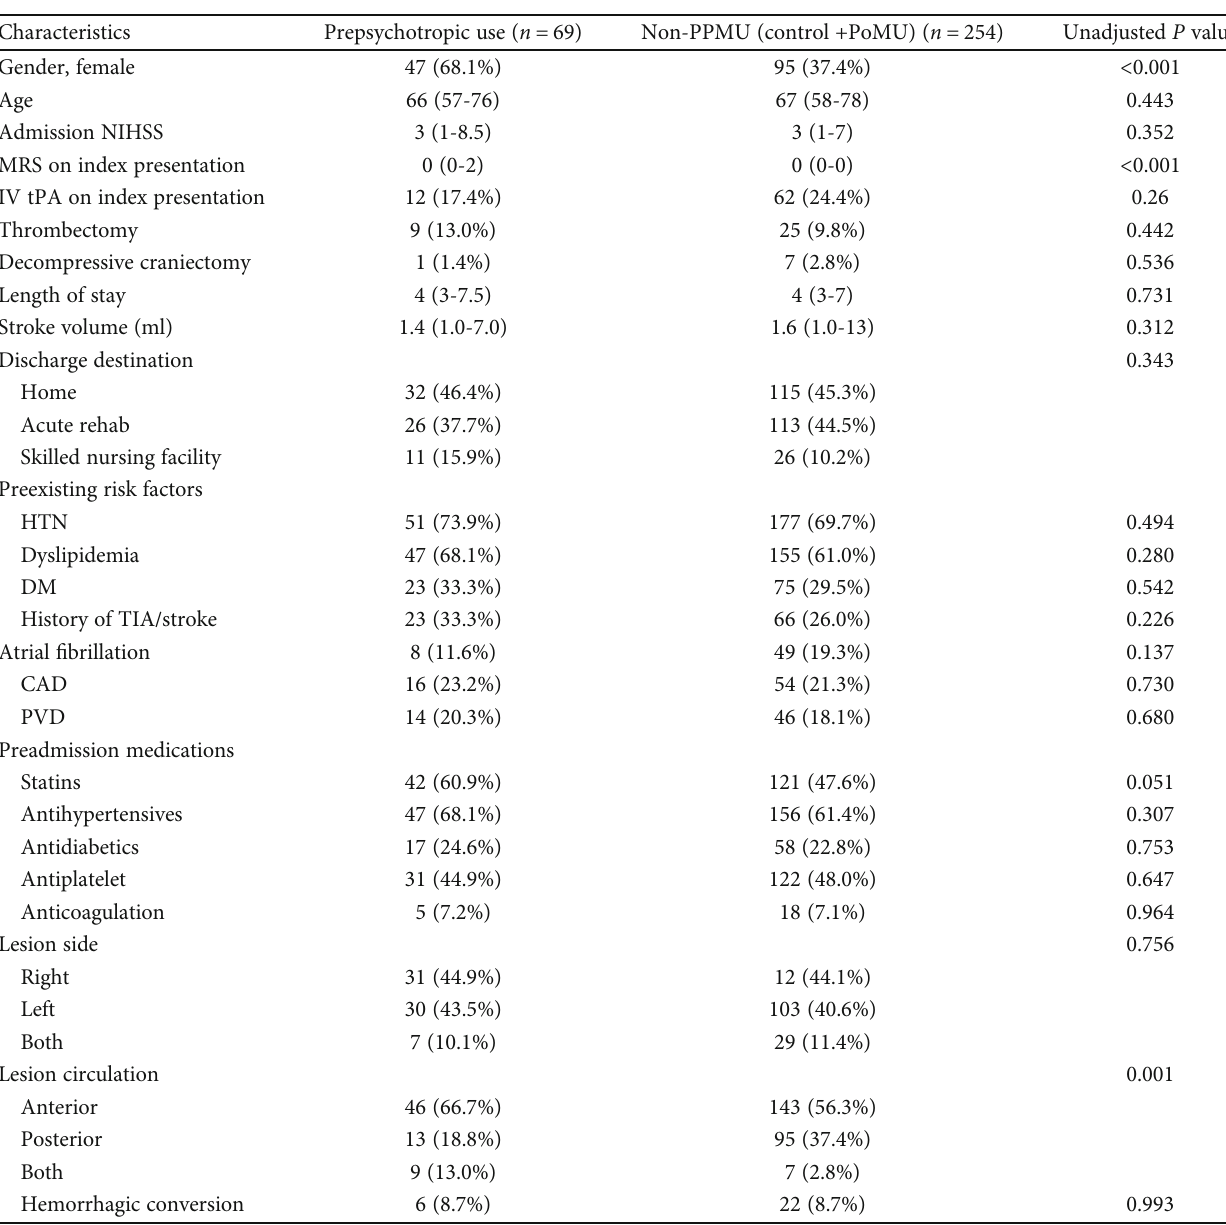
Table 2: Patient